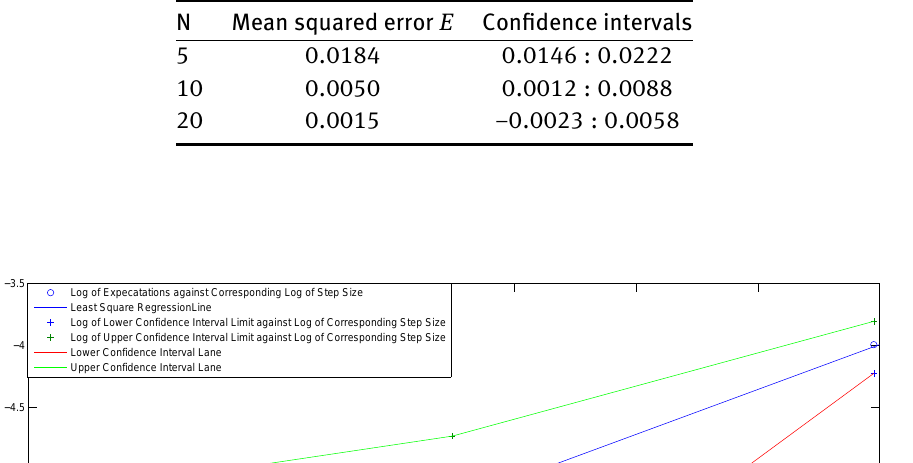
Table 1: Mean squared error.